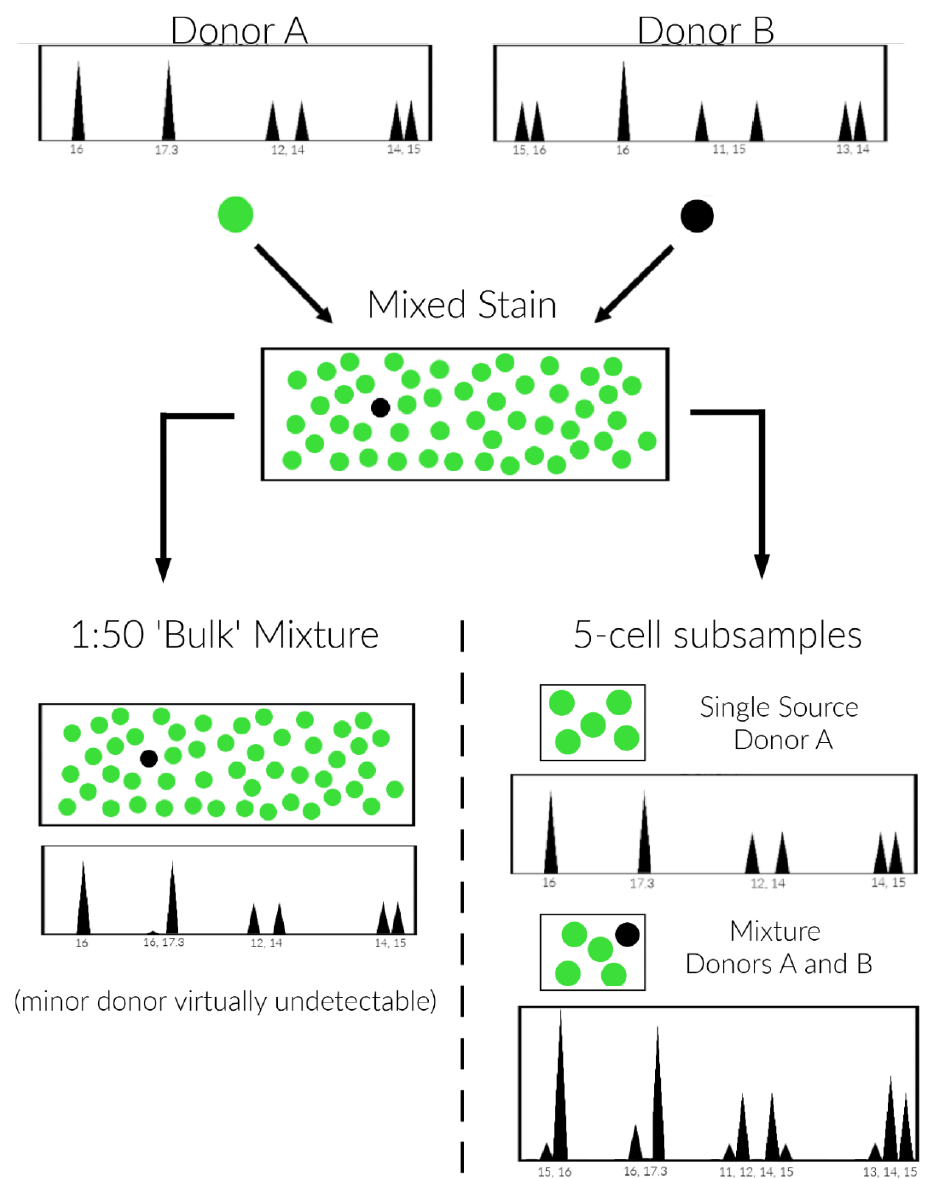
Figure 1. Undetectable/unresolvable minor donor analysis scheme. Standard “bulk” sampling re-